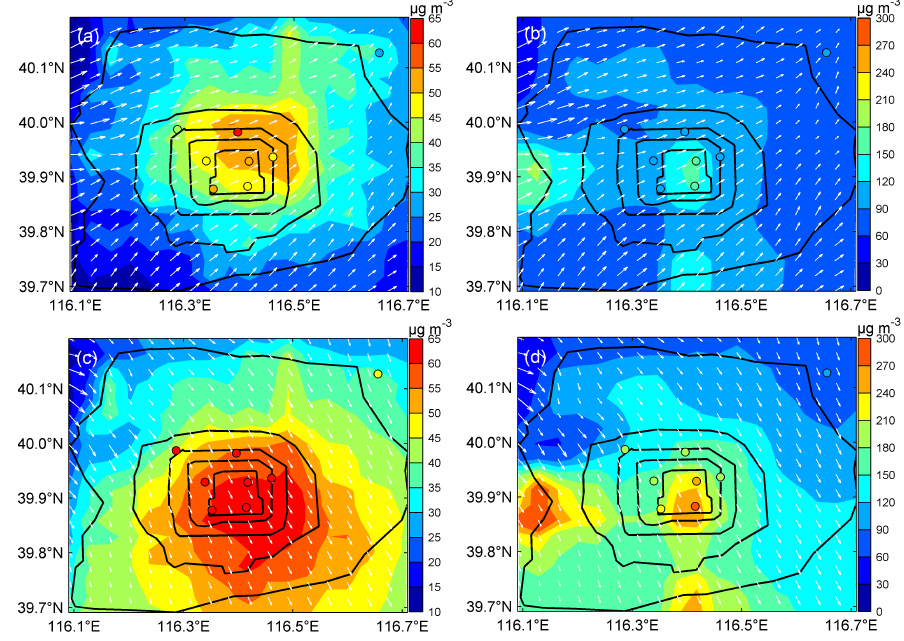
Figure 3. The spatial distribution of near-surface NO 2 and PM 2 . 5 mean concentration from SIM2 in July (a, b) and December (c, d) 2013 respectively. Black lines represent the main traffic arteries in Beijing; scatter represents the mean concentrations of sites observation; white arrows represent near-surface mean wind